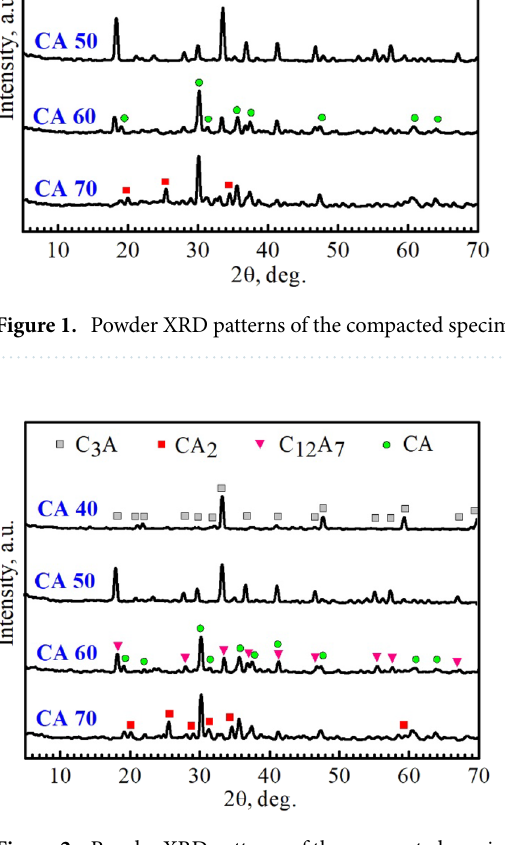
Figure 2. Powder XRD patterns of the compacted specimens sintered at 1350